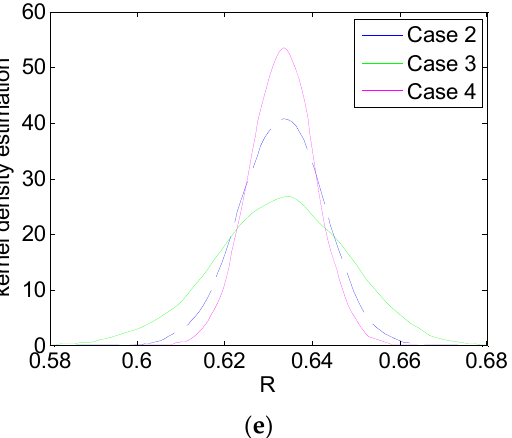
Figure 5. Probability density functions of system reliability for case 1 to case 4. ( a ) System reliability probability density function in case 1; ( b ) System reliability probability density function in case 2; ( c ) System reliability probability density function in case 3; ( d ) System reliability probability density function in case 4. ( e ) The comparison of system reliability probability density functions of different cases. Table 1. Means and variances of system reliability in four cases ( T = 7 h, M = 1000). Case 1 Case 2 Case 3 Case 4 Mean 0.6335 0.6332